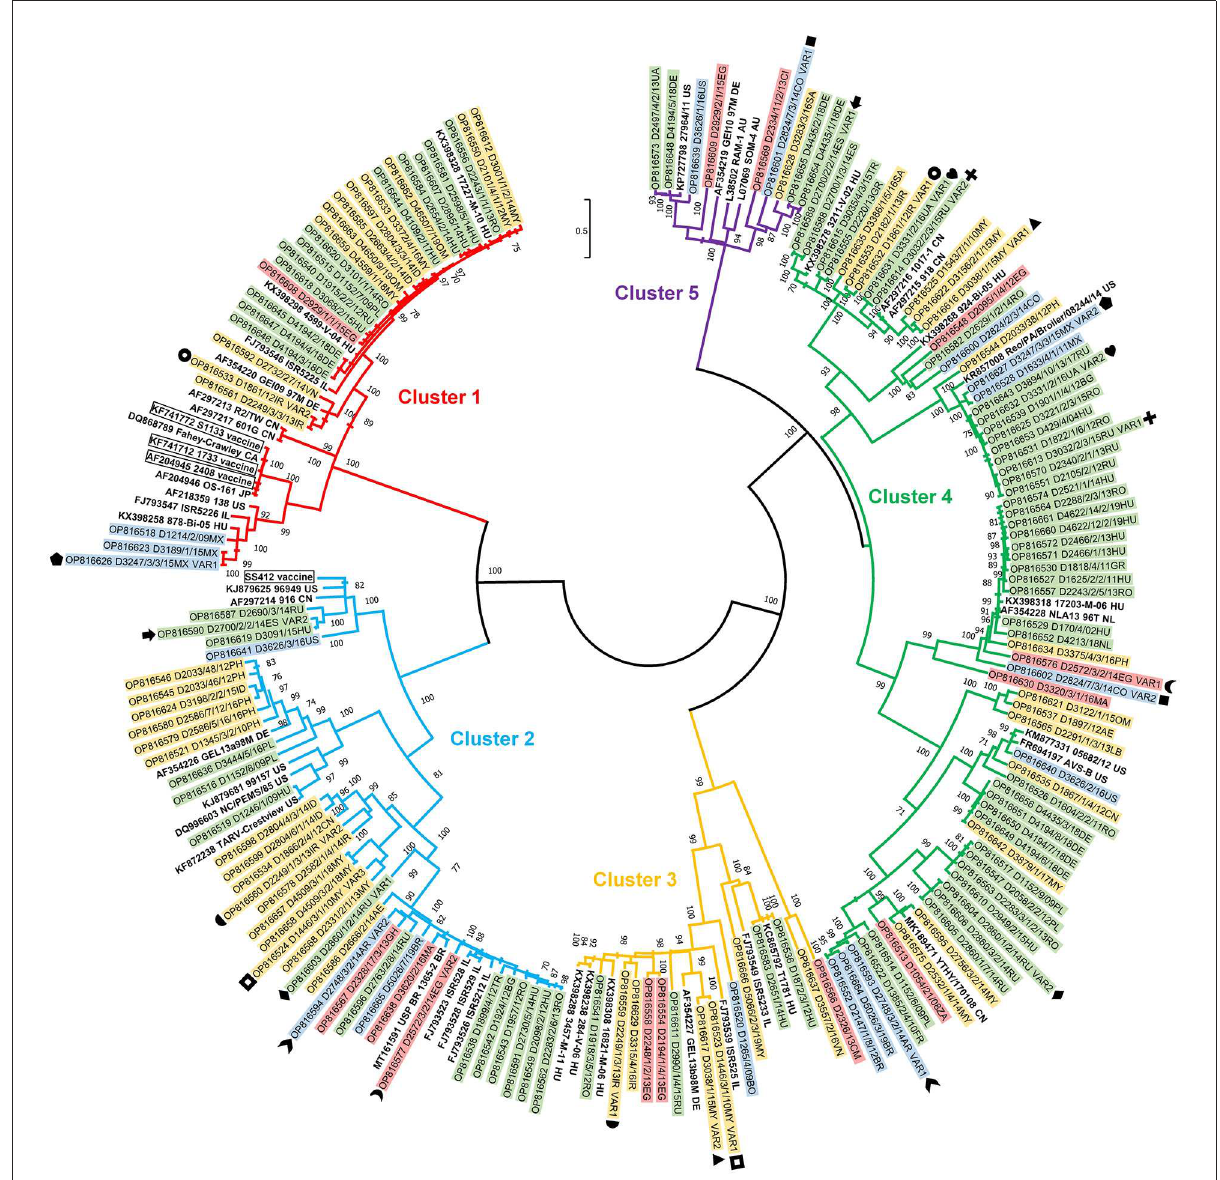
FIGURE6 Phylogenetic tree of detected ARV strains based on the partial amino acid sequence coded by the σ C